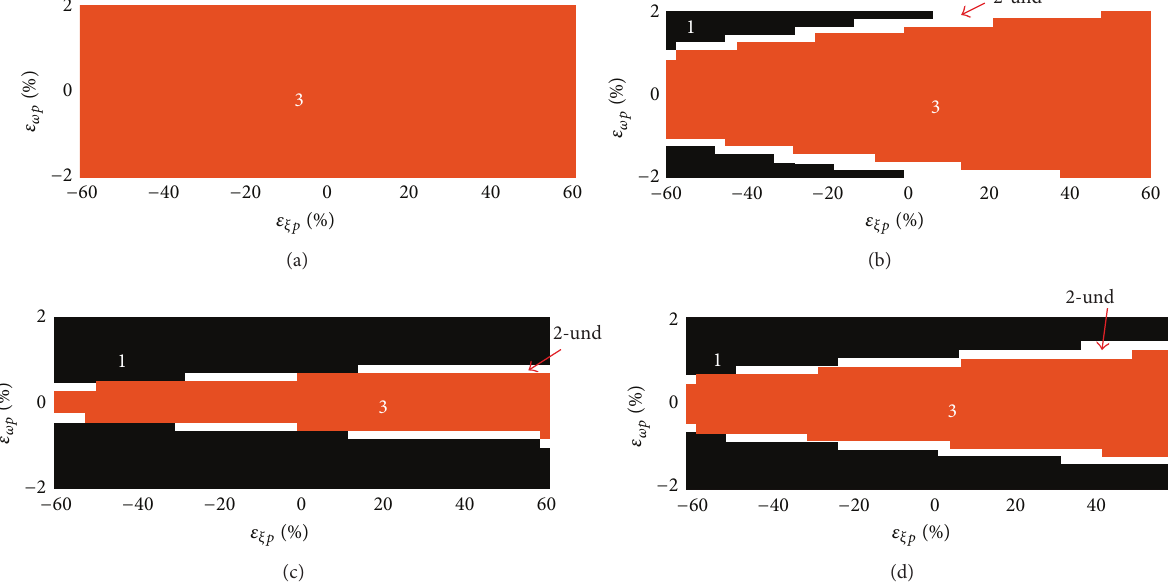
for a given bias on 𝜉 𝑝 and 𝜔 𝑝 . (a) Case 13 𝑘